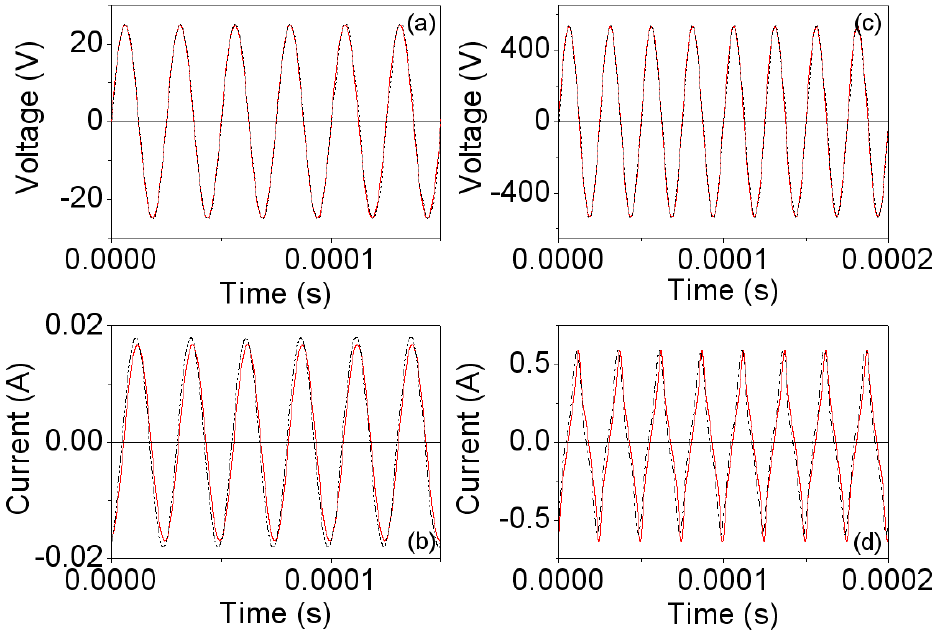
curve; and ( b ) P - I rms